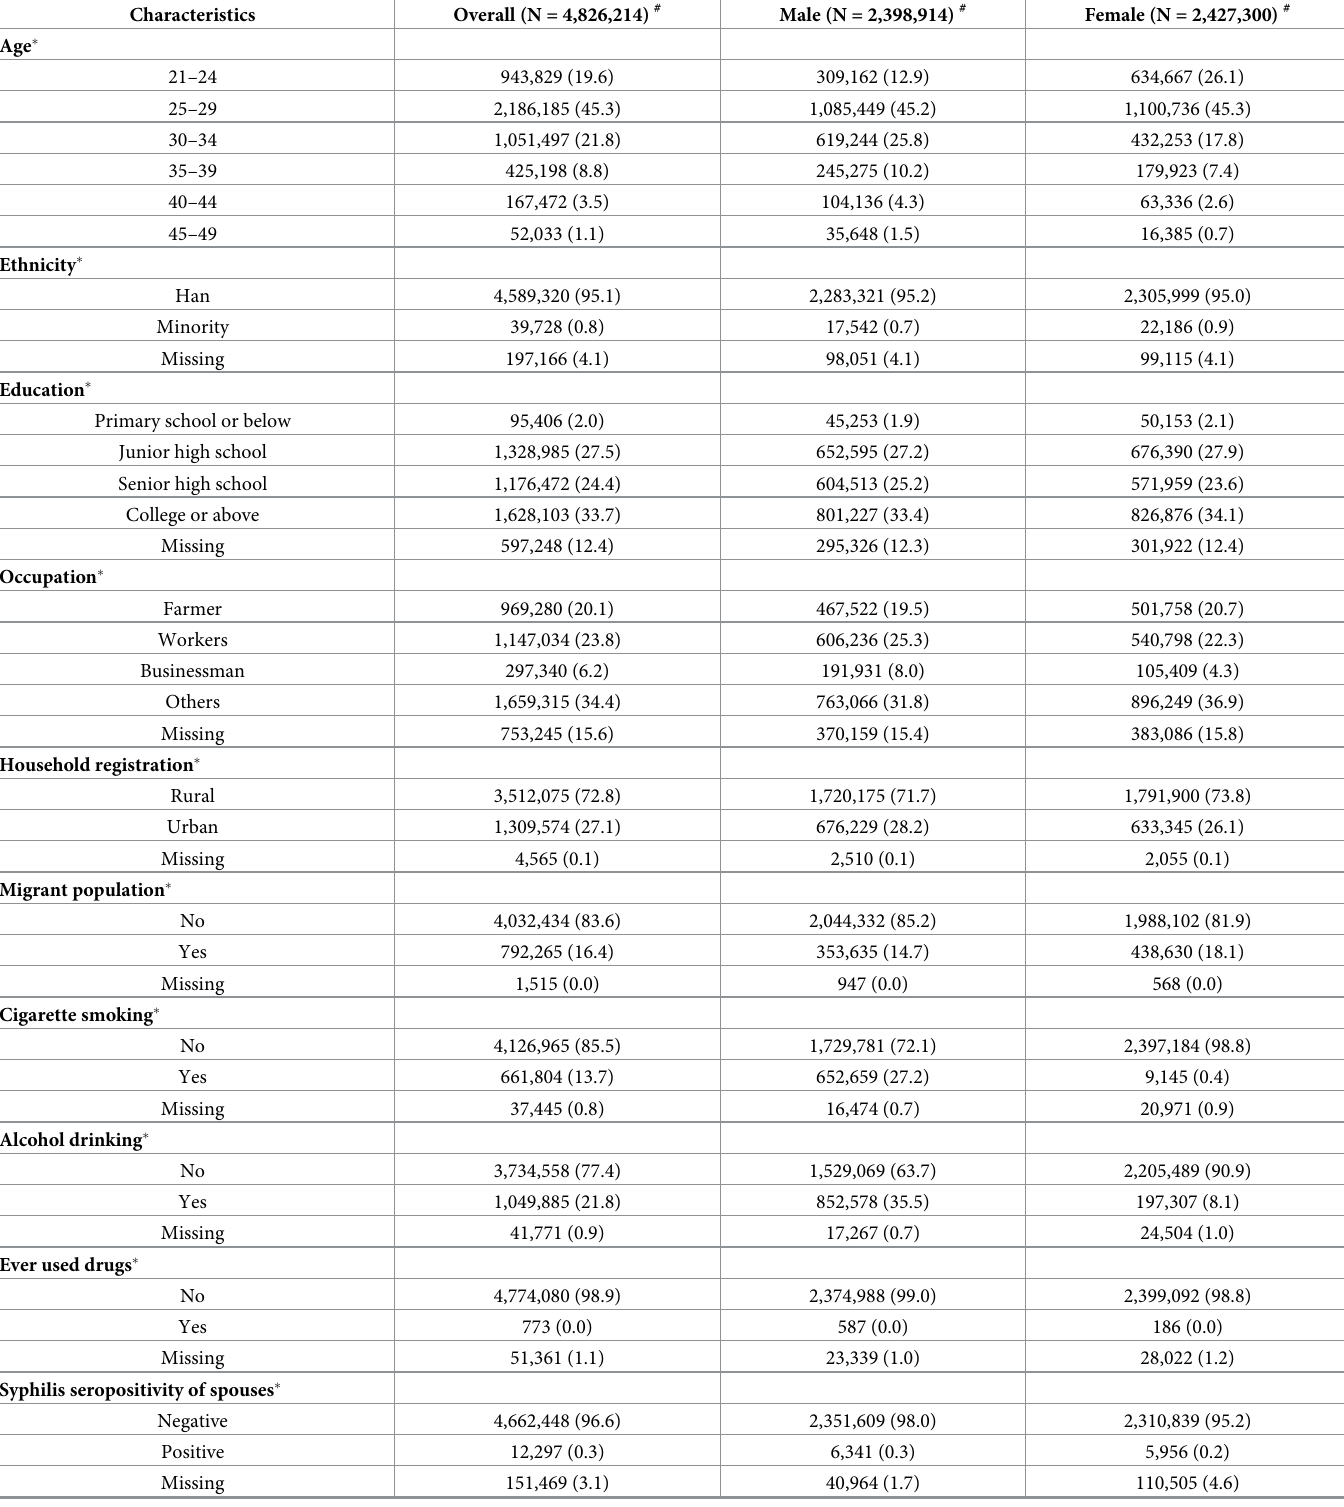
Table 1. Sociodemographic characteristics of married individuals aged 21–49 who participated in NFPHEP in Guangdong, 2014–2019.